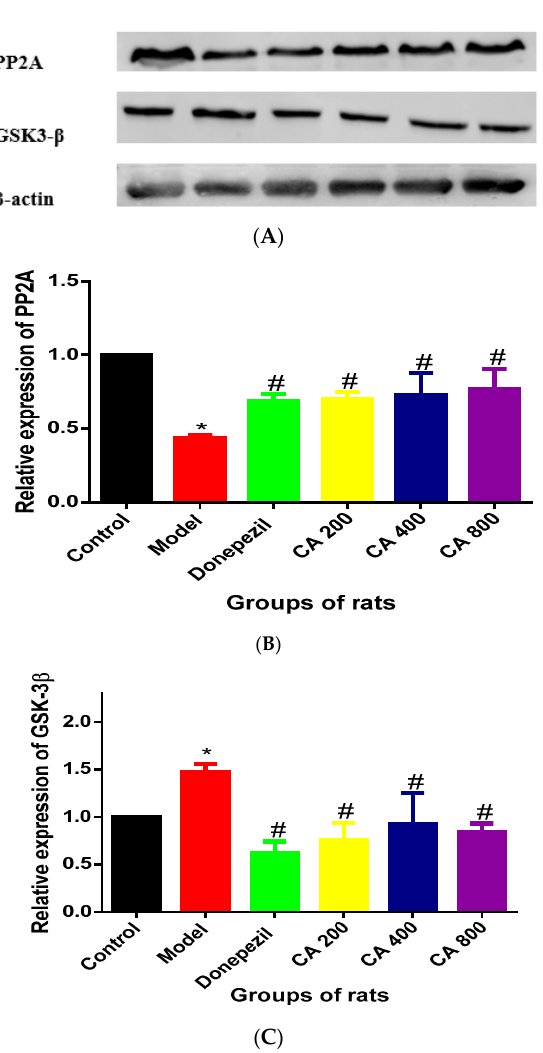
Figure 1. Expressions of PP2A and GSK3- β in rat’s hippocampus. ( A ) Immunoblots of Levels of PP2A and GSK3- β in D -gal and AlCl 3 induced rats. ( B ). Immunoblot analysis showed dose-dependent increases in PP2A activities. ( C ). Immunoblot analysis showed decreases of GSK3- β activities. ImageJ software (NIH, Bethesda, MD, USA) was used for densitometry. Values are expressed as mean ± SD ( n = 3), * p < 0.05 vs. control, # p < 0.05 vs. the model group of rats.